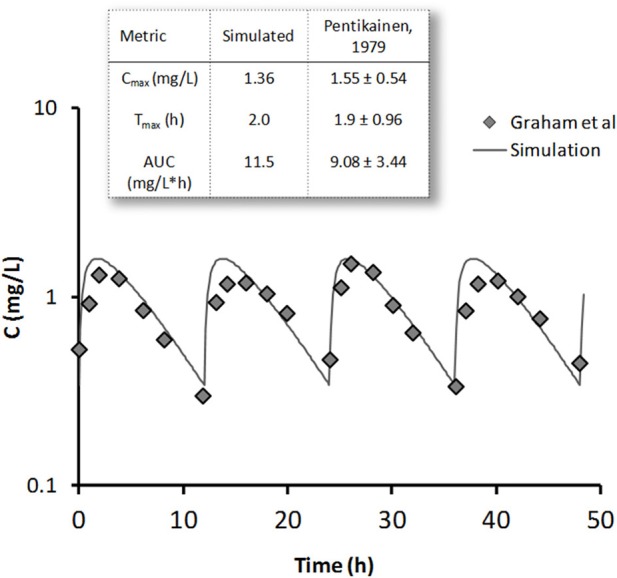
Metformin simulated steady-state concentration profile (line) is plotted against clinical data (diamonds) (Graham et al., 2011) for 500 mg bid dose regimen. On the inset single 500 mg dose simulation results are compared with data from Pentikainen et al. (1979) (mean ± SE) for metformin peak concentration Cmax, time to peak Tmax, and area under the curve (AUC).